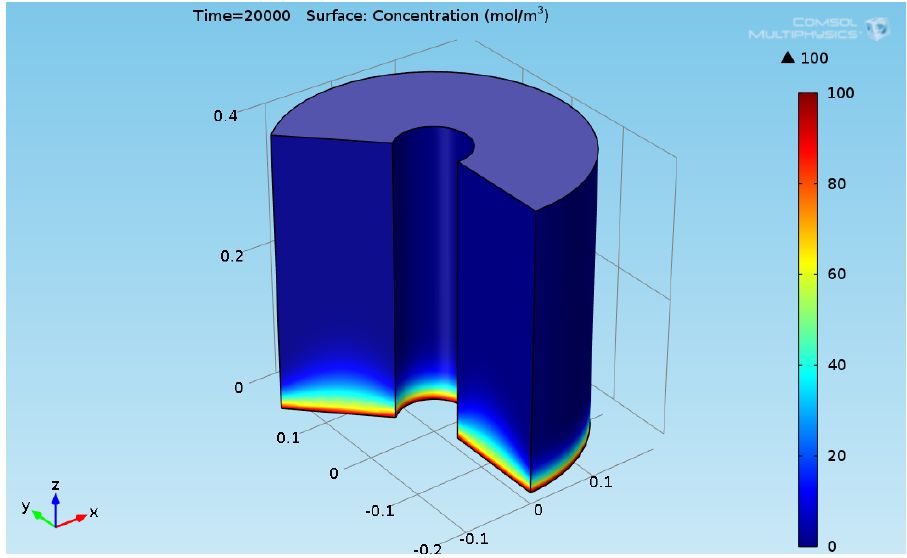
Figure 9. 3D plot of the concentration field of the oleic acid inside the esterification reactor.